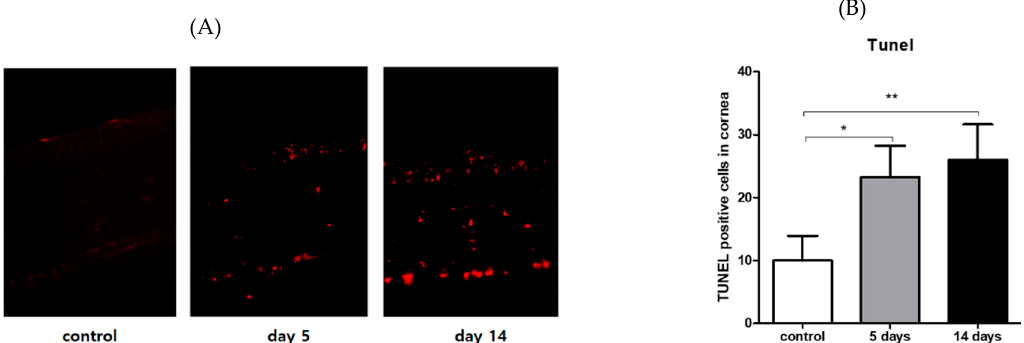
Figure 5. Quantitation of TUNEL-positive cells in the corneal epithelial layer. ( A ) Representative photograph of TUNEL staining of the cornea in both groups. ( B ) The number of apoptotic cells (red) in PM 2.5 -exposed corneas was significantly increased as compared to the vehicle control. p -value signs indicate * p < 0.05; ** p < 0.001. Data are presented as the mean ± SEM of three experiments. Each experiment consisted of three to four corneas per group.